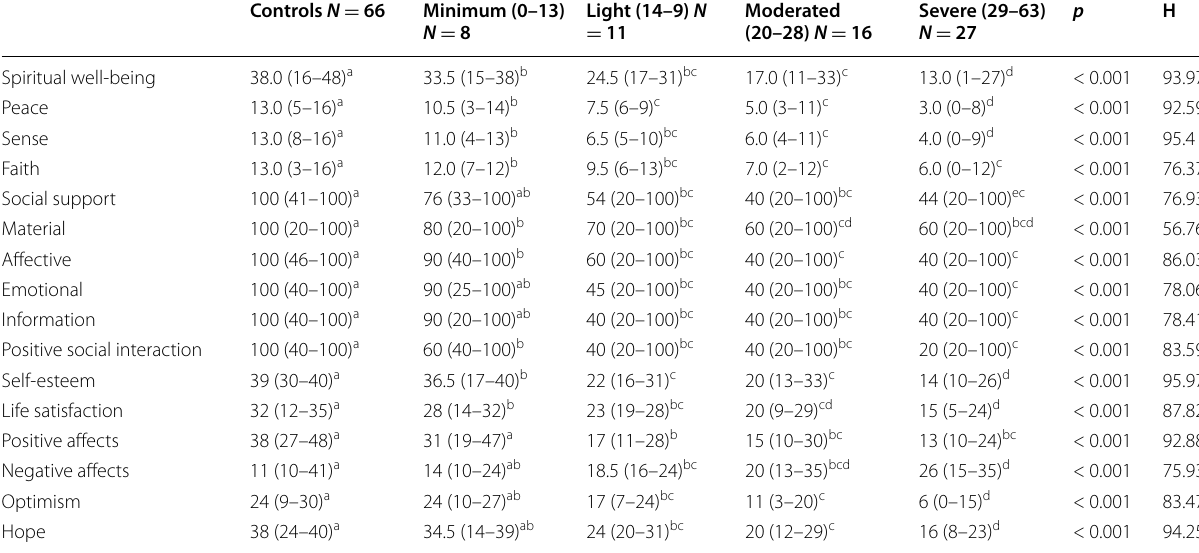
*a,b,c,d Different letters indicate significant difference (Kruskal-Wallis with post hoc U of Mann-Whitney with Bonferroni significance correction) ** Values presented in median and amplitude — m (min-max)